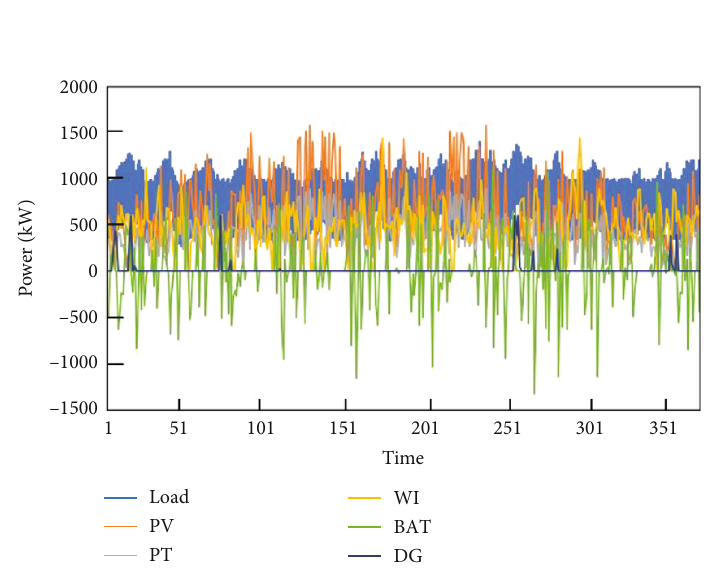
Figure 14: Annual distributed power output and load of microgrid.